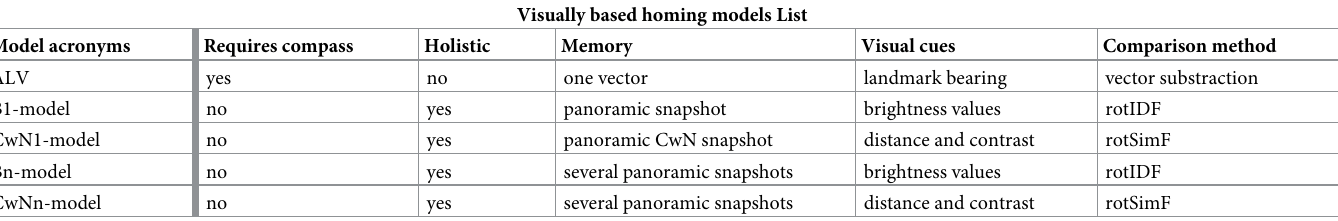
Table 1. Main criteria distinguishing the different tested models: The need for a compass, the type of cue, its holistic nature, the memory and the mechanism used for comparison between the current visual information and the memory. CwN stands for the contrast of the image weighted by the nearness, rotIDF for the rotational image difference function and the rotSimF for the rotational similarity function. Models original names are mentioned in the method section and Fig